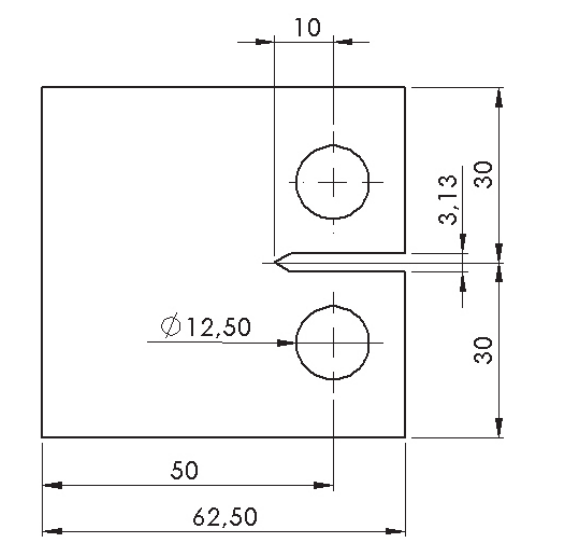
Figure 2: Detail of the CT50 specimen.